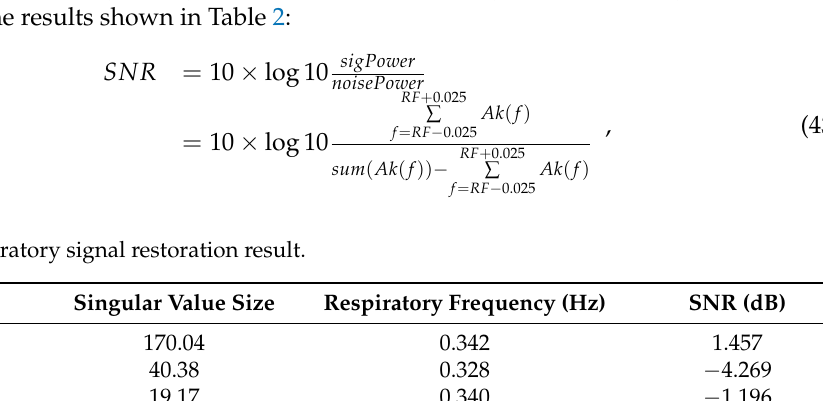
Table 2. Respiratory signal restoration result.